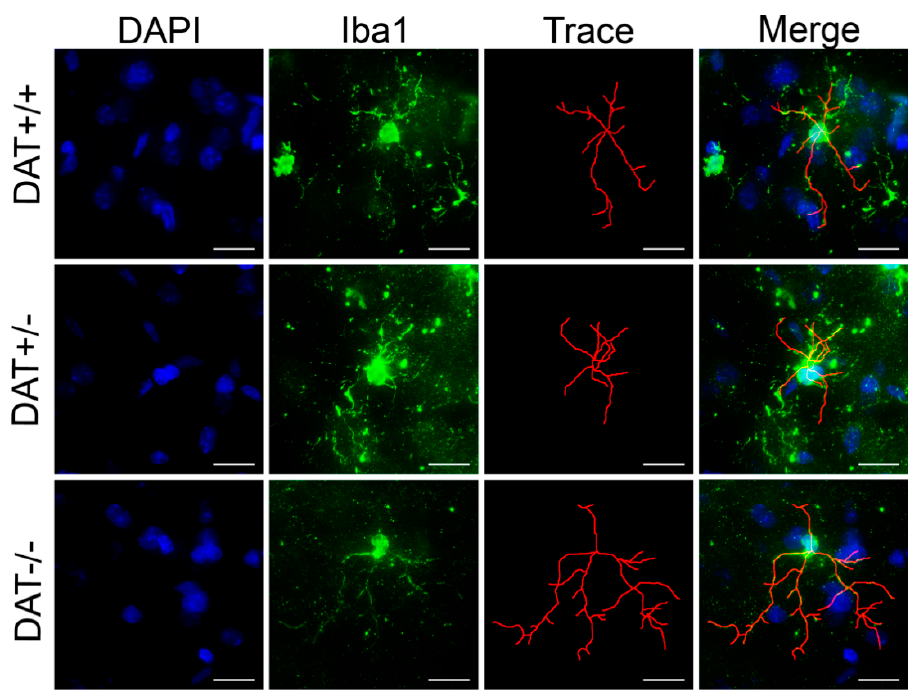
Figure 6. Fluorescence microscopy images display arborization of Iba1+ cells and their 3D mor- phometric reconstruction in DAT+/+, DAT+/ − and DAT − / − rats, highlighting an increase in the number and length extension of microglial branches in the PFC of DAT − / − female rats. Scale bar: 5 μ m.